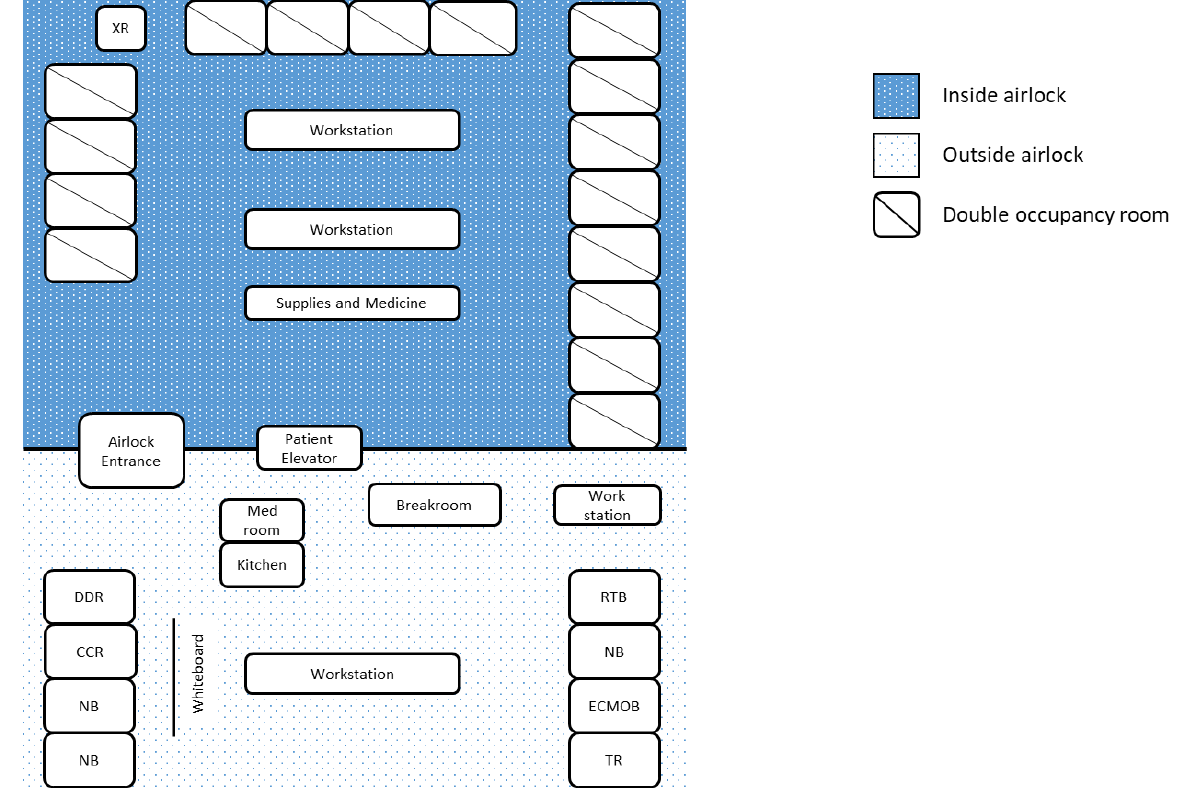
Figure 3. COVID-19 biocontainment unit schematic. Legend: DDR—donning and doffing room, ECMOB—ECMO specialist breakroom, CCR—communication command room, NB—nurses’ breakroom, RTB—respiratory therapist breakroom, TR—tranquility room, XR—portable x-ray machine.